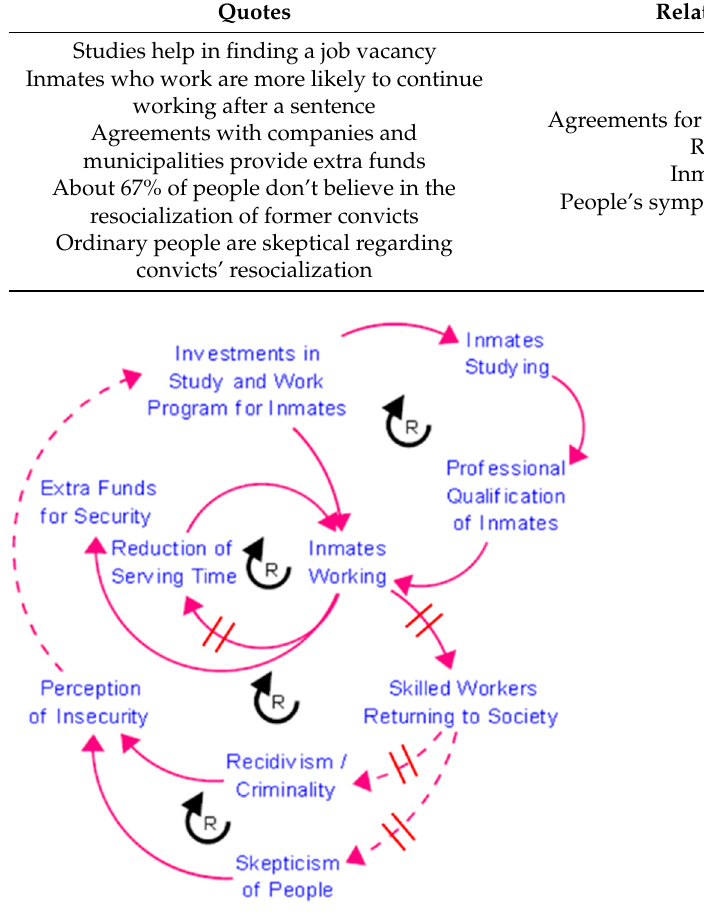
Figure 6. CLD of